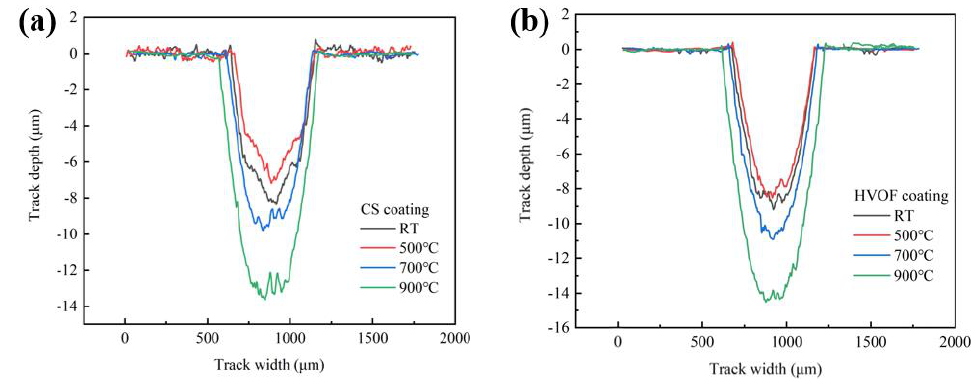
Figure 13. Wear cross-sectional volumes of CoCrFeNiMn high-entropy alloy coatings. ( a ) CS coatings; ( b ) HVOF coatings.